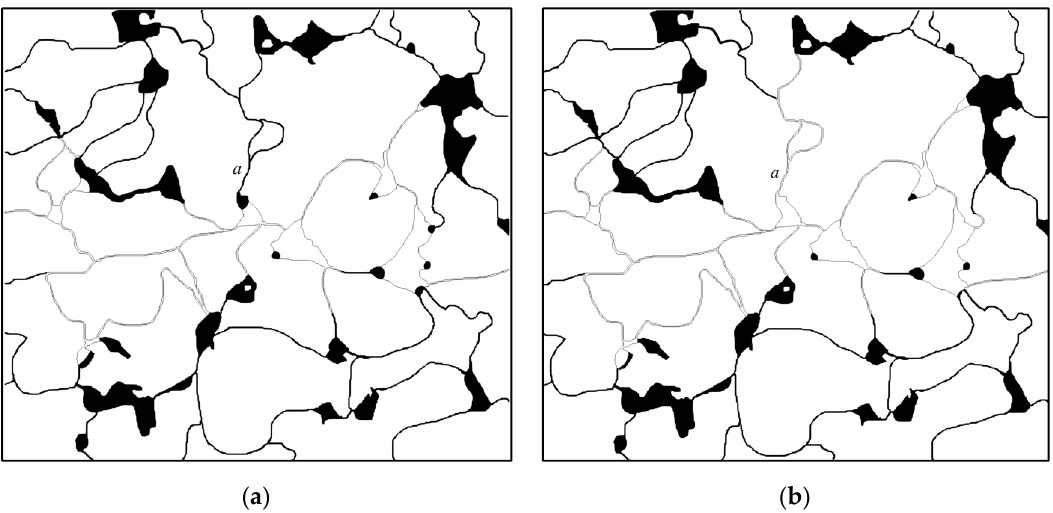
Figure 16. The final oil and water distribution at different absolute viscosities, with a viscosity ratio of 20: ( a ) the effective viscosity of water is 0.001 kg m − 1 s − 1 and oil is 0.02 kg m − 1 s − 1 ; ( b ) the effective viscosity of water is 5 × 10 − 4 kg m − 1 s − 1 and oil is 0.01 kg m − 1 s − 1 . Different positions are indicated by lower case letters .